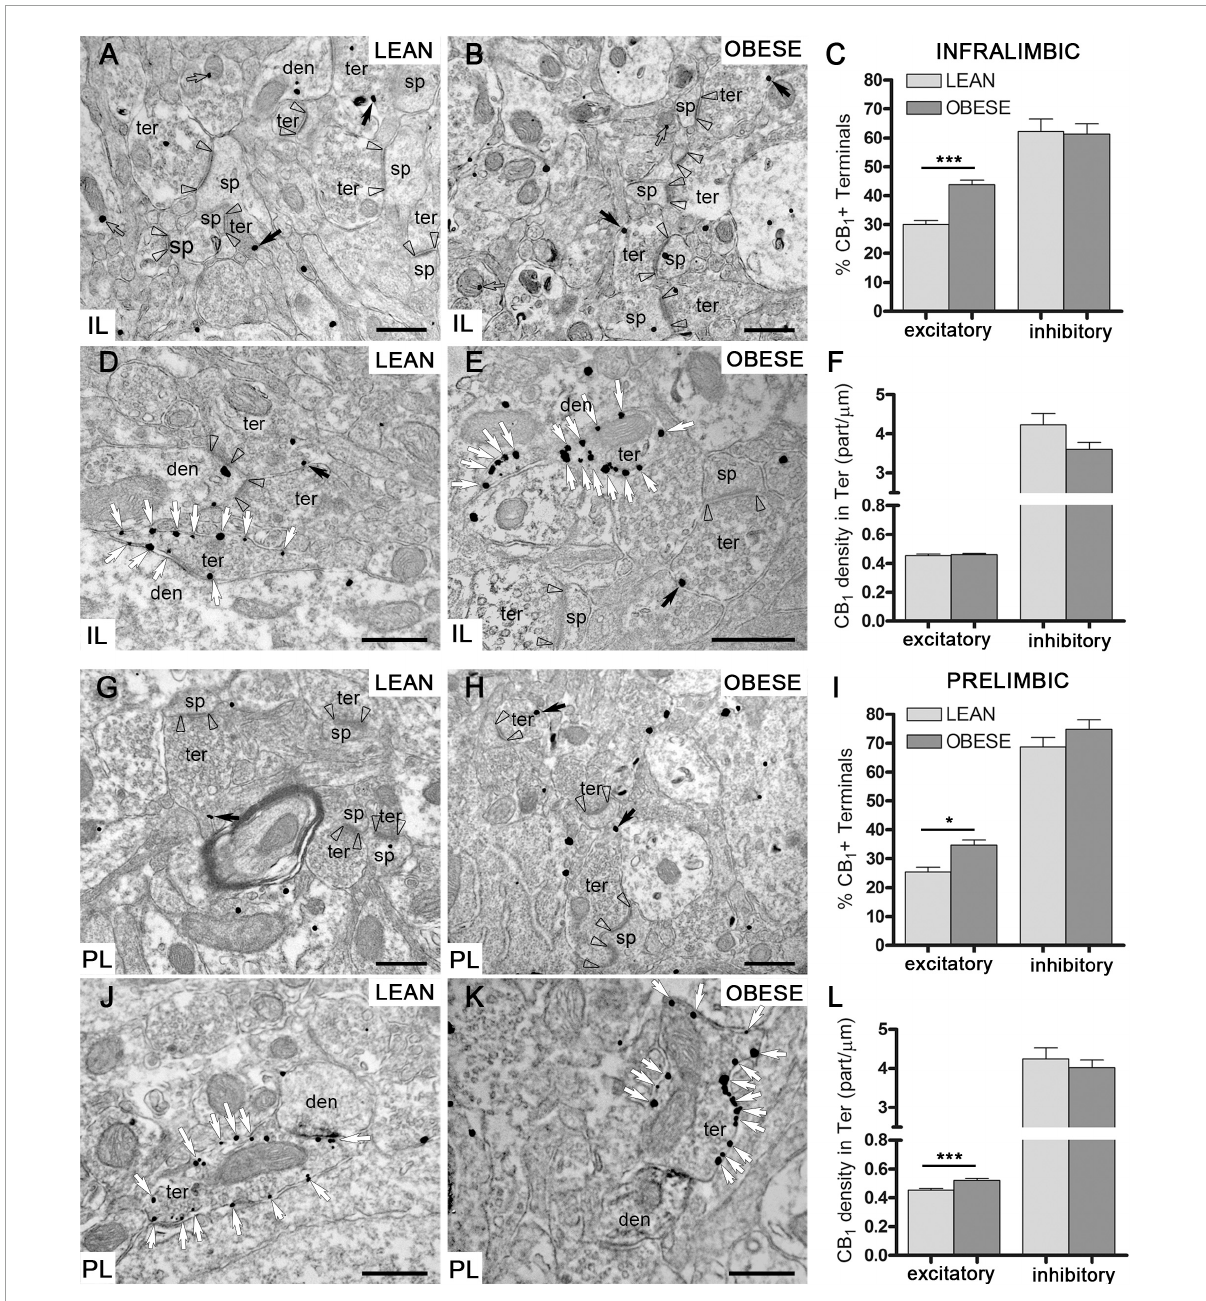
FIGURE7 CB 1 receptor distribution by preembedding immunogold-silver staining for electron microscopy. (A–F) CB 1 receptor particles at excitatory (A,B) and inhibitory (D,E) synaptic terminals in IL of lean and obese Zucker rats. Percentage of excitatory and inhibitory terminals with CB 1 receptor labeling (C) and density of CB 1 particles at excitatory and inhibitory terminals in IL (F) . (G–L) CB 1 receptor labeling at excitatory (G,H) and inhibitory (J,K) synaptic terminals in PL of lean and obese Zucker rats. Percentage of excitatory and inhibitory terminals containing CB 1 particles (I) and density of CB 1 labeling at excitatory and inhibitory terminals in PL (L) . Arrowheads: excitatory synapses; black arrows: CB 1 receptor immunoparticles in excitatory terminals; white arrows: CB 1 receptor immunoparticles in inhibitory terminals; ter, terminal; den, dendrite; sp, dendritic spine. Scale bars = 0.5 µ m. Data are mean ± SEM (Mann–Whitney test; * P < 0.05, *** P < 0.0001).